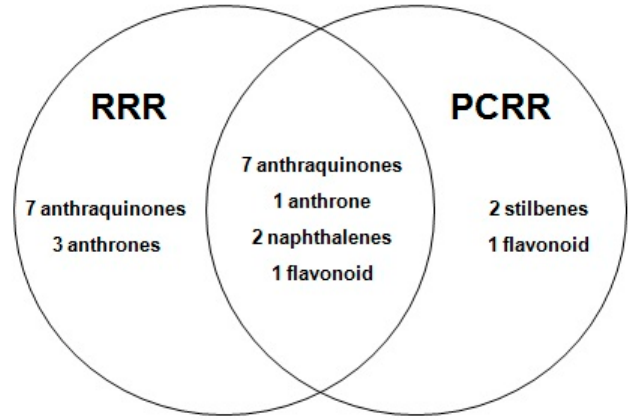
Figure 3. The compounds identified in Rhei Radix et Rhizoma (RRR) and Polygoni Cuspidati Rhizoma et Radix (PCRR).